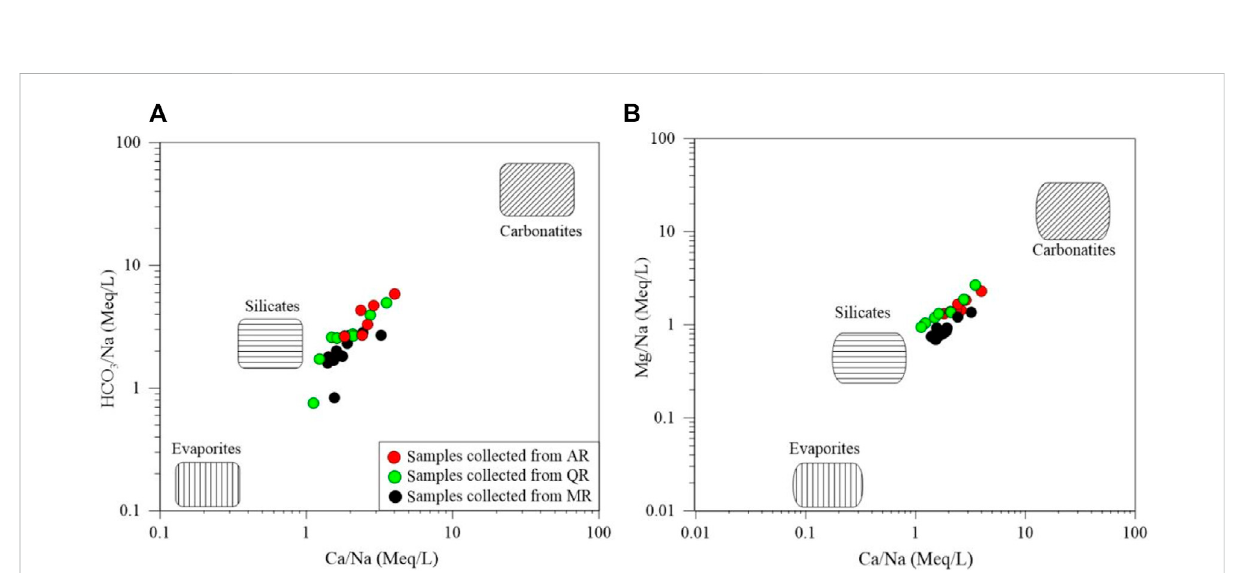
FIGURE 5 Bivariate diagrams of (A) (HCO 3 /Na) vs. (Ca/Na), and (B) (Mg/Na) vs. (Ca/Na) for surface water samples in the study